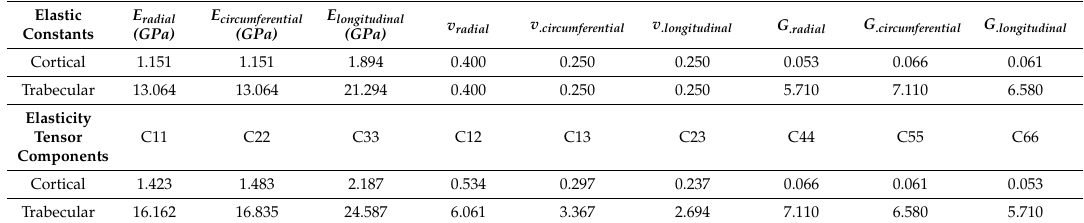
Table 1. Sti ff ness matrix components imported into Ansys.